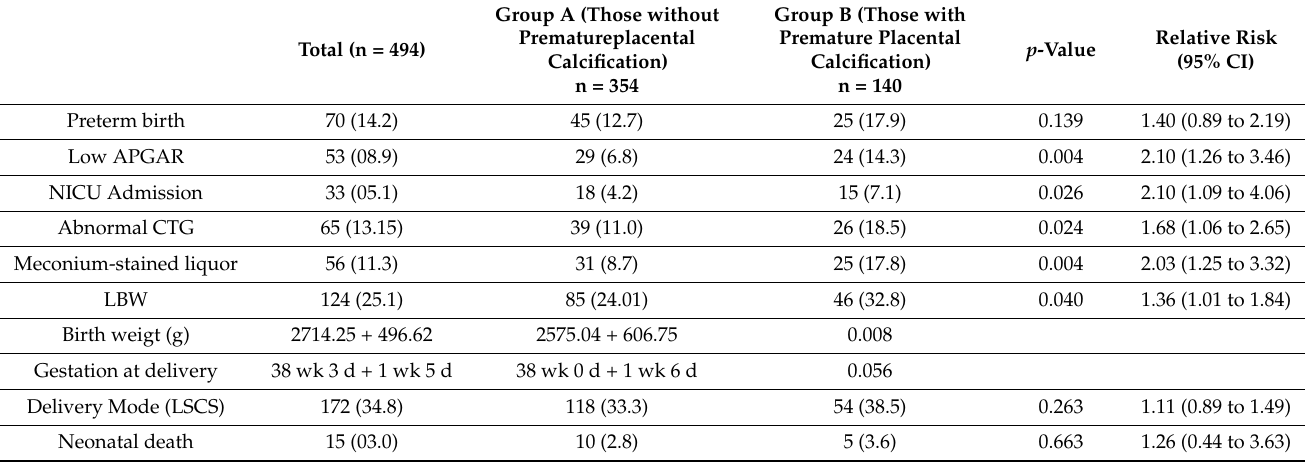
Table 3. Perinatal outcome for the selected cohort of pregnant women.